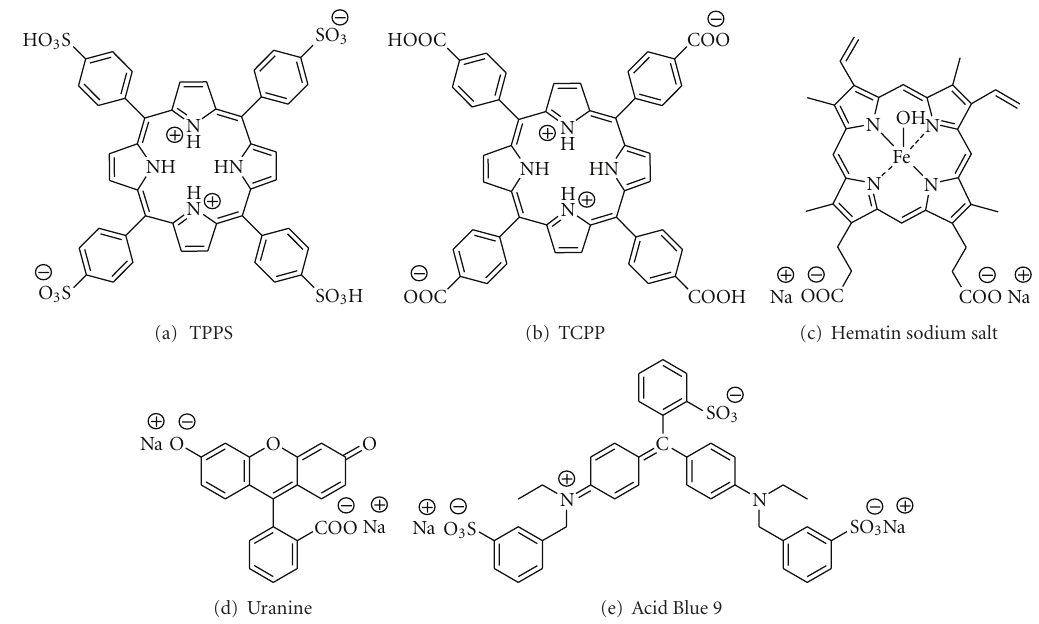
Figure 5: Structures of various dye